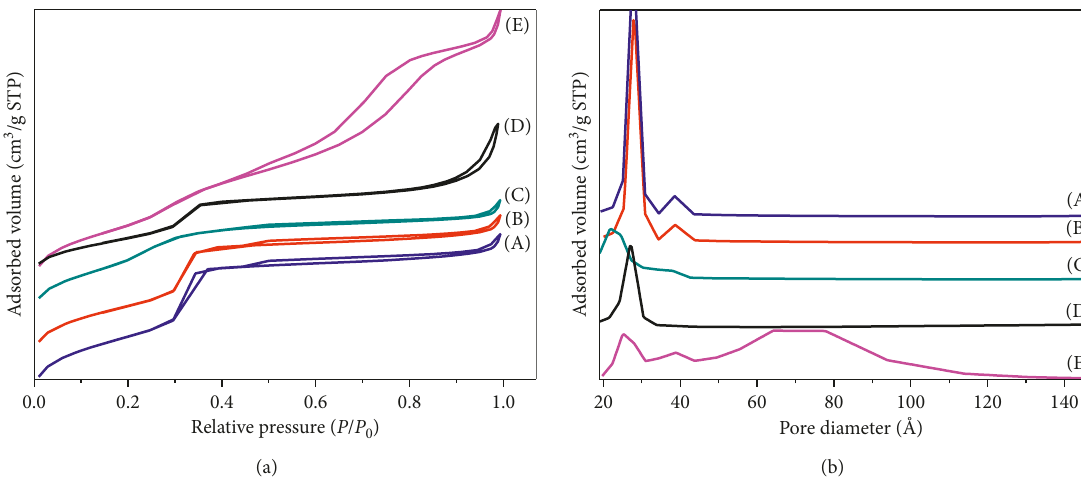
Figure 2: (a) N 2 adsorption-desorption isotherms at 77K and (b) BJH pore-size distributions of (A) LUS and MnLUS (7 wt.%),